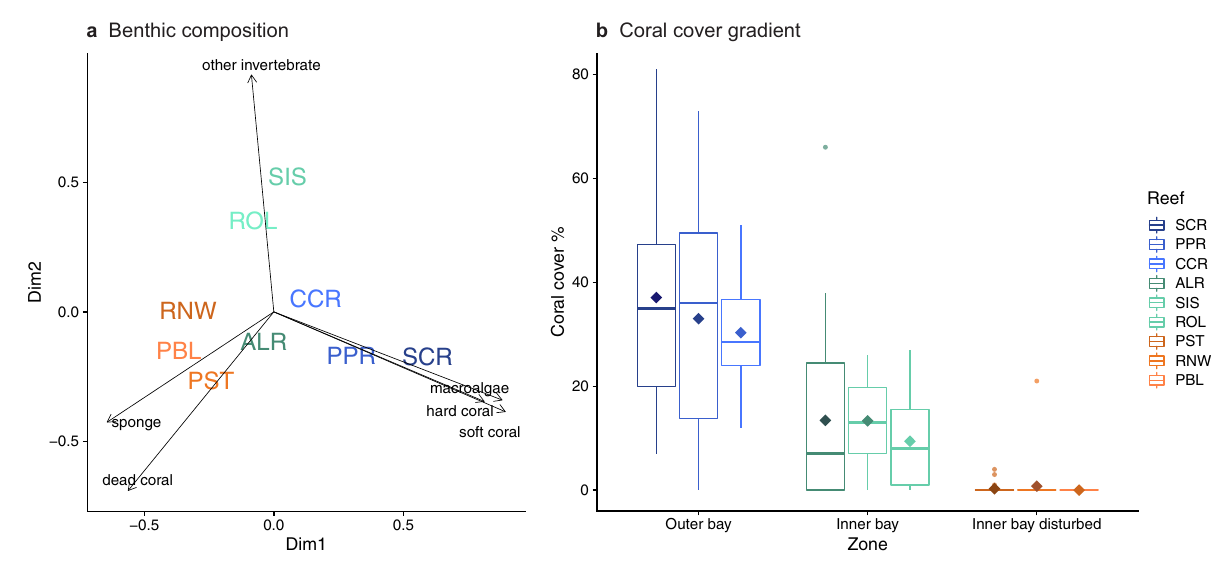
Fig. 2 Benthic communities. Composition and percent coral cover of benthic communities across nine reefs and three reef zones illustrating a habitat gradient: a PCoA representing dissimilarities in benthic community composition based on Bray – Curtis. Reefs are color-coded by reef zone, substrate groups are depicted in black; b percent live coral cover across reef zones from high coral cover at the outer bay to very low cover on disturbed reefs at the inner bay. Diamond shapes depict